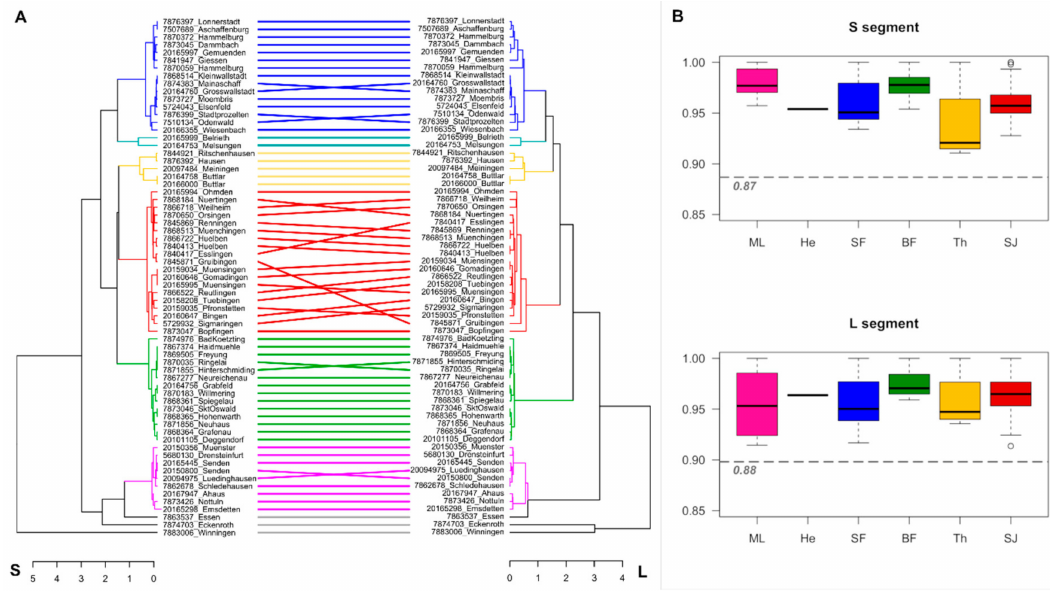
Figure 3. ( A )—Tanglegram of human-derived PUUV sequences based on phylogenetic trees of the S (left side) and L (right side) segments. ( B ) Boxplots showing the pairwise identities (PWI) within defined phylogeographic clusters. Gray dashed line, and the number below indicates the mean PWI between all sequences in the dataset (87% and 88% for S and L segment alignment, respectively). Colors indicate phylogeographic regions: Pink = Muensterland, turquoise = North-East Hesse, blue = Spessart Forest, green = Bavarian Forest, yellow = Thuringia, red = Swabian